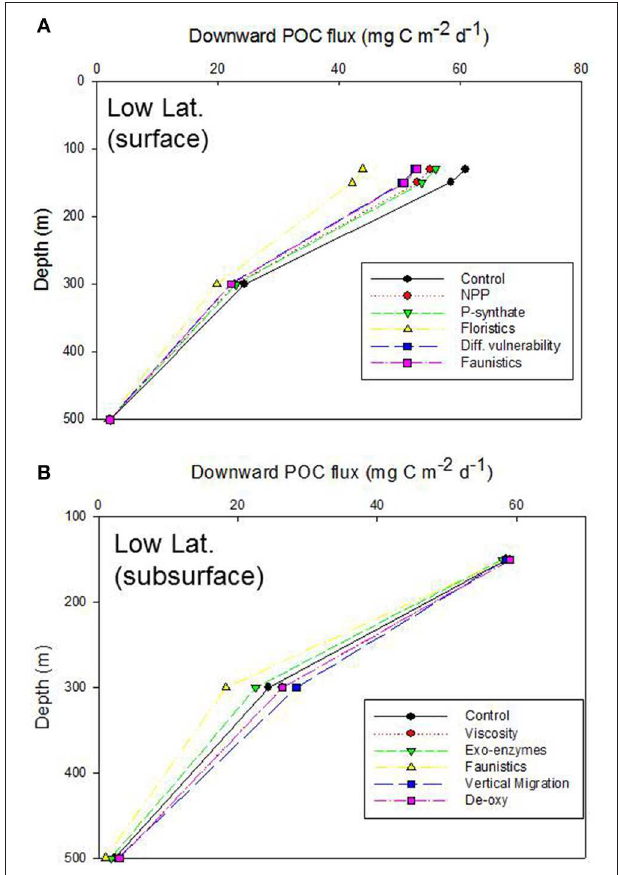
FIGURE 4 | Vertical profile of projected downward POC flux for the control run, high latitude case. Note that the profile for the Viscosity run is overlaid by that for De-oxygenation. (A) Additional simulations represent the systematic alteration of the individual components of the pump for the surface ocean: NPP, increased NPP; P-synthate, NPP directed to bacteria resulting in increased BP; Floristics, altered size-partitioning of NPP; Diff. vulnerability, altered microzooplankton trophic transfer efficiency; Faunistics, altered mesozooplankton trophic transfer efficiency. (B) As for (A) , but the simulations represent the systematic alteration of the pump components for subsurface waters: Viscosity, decreased seawater viscosity increasing particle sinking rates; Exo-enzymes, more microbial activity; Faunistics, altered mesozooplankton trophic transfer efficiency; Vertical migration, altered vertical POC shunt; De-oxy, decreased microbial remineralization due to de-oxygenation.